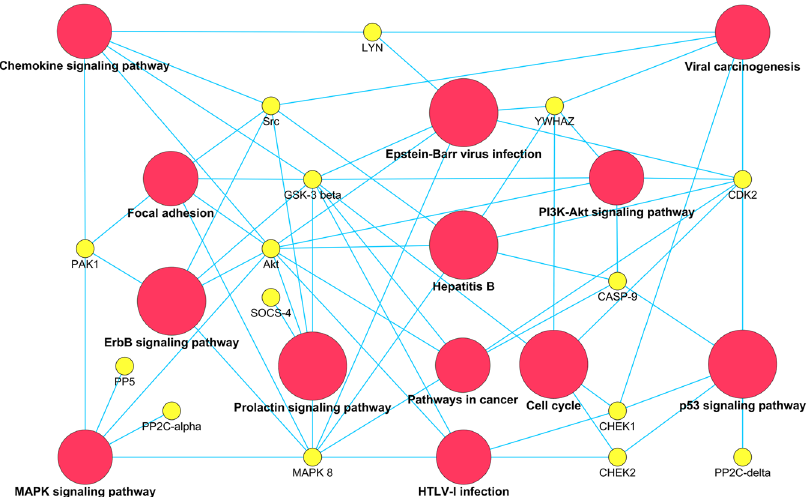
Figure 6. Representation of KEGG pathways significantly regulated by S75X and p17R76G. The proteins modulated by p17s were used as input for the Cytoscape ClueGO functional analysis tool to cluster the proteins according to the KEGG pathways database. The proteins are represented by yellow circles. The pathways are represented by red circles and the circle size is directly proportional to statistical relevance (3 * 10 − 3 > p < 8 * 10 − 6 ). An edge is present when the protein is involved in the